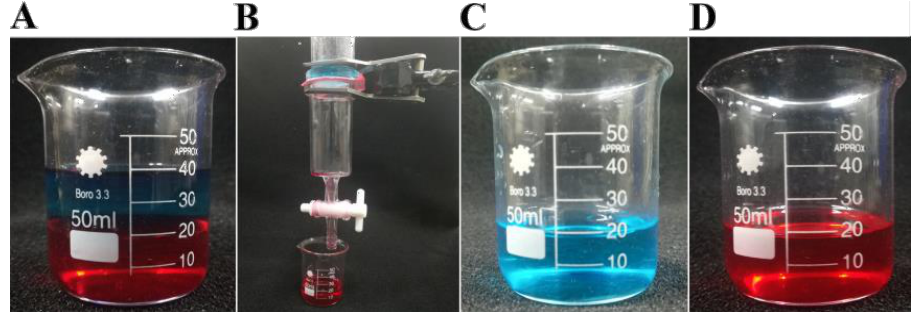
Figure 9. The separation of oil from oil–water mixture by the modified fabric ( A ) mixture of DCM red oil and blue water, ( B ) pour into the oil–water separation device, ( C ) amount of water, and ( D ) amount of purifying DCM.